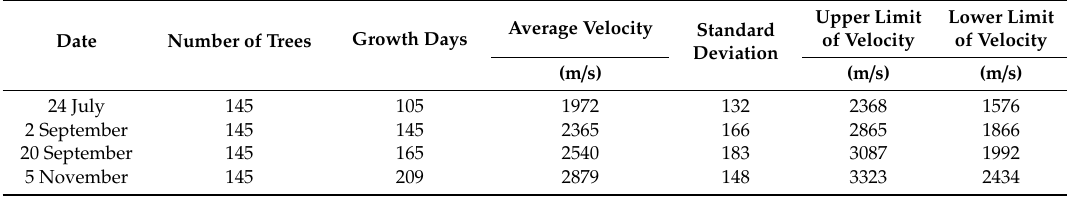
Table 2. Results of statistical analysis for ultrasonic velocity and growth days